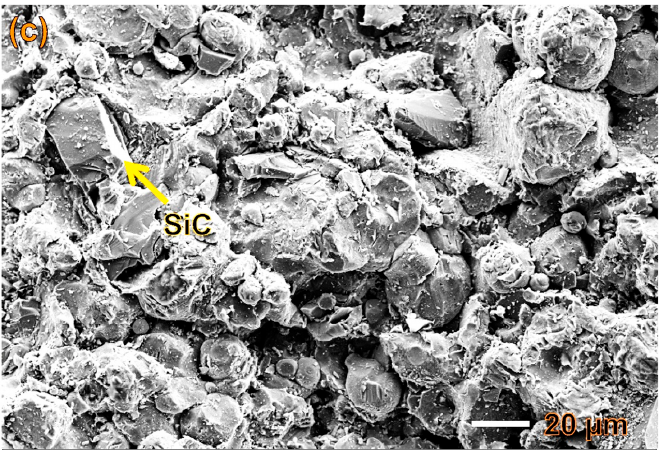
Figure 1. Top surfaces of the ( a ) cold-sprayed Al 5056, ( b ) Comps1 and ( c ) Comps2 coatings. Figure 2 shows the full-thickness, cross-sectional SEM micrographs of the cold-sprayed Al 5056 coating and SiC p /Al 5056 composite coatings. The dark region on the top is the resin used to embed the sample, the uniformly grey area at the bottom is the Mg substrate, and the area between these two regions is the cold-sprayed coating. The pores can be identified as dark dots.